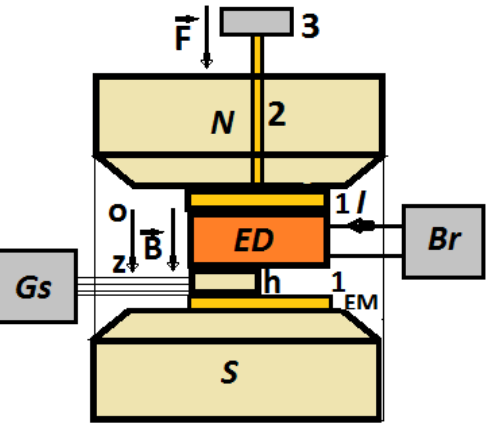
Figure 7. Experimental set-up (overall configuration): EM — electromagnet; N and S — magnetic poles; Br — impedance meter; Gs — gaussmeter; h — Hall probe; B — magnetic flux density vector; F — gravity force; ED — electrical device; 1 — non-magnetic plate, 2 — non-magnetic spindle, 3 — non-mag- netic weight.